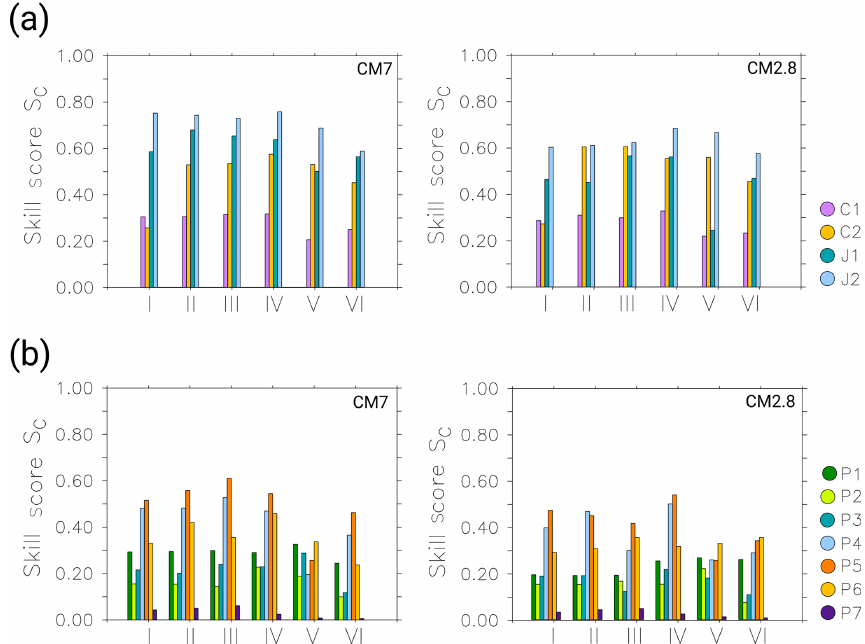
Figure 16. The bar plots show the calculated skill scores S C for the comparison of forecast days one to six (horizontal axis) to the obser- vations. The colours refer to the different observations. Panel (a) displays the results for C1, C2, J1 and J2. Panel (b) shows the results for P1–P7. The CM7 and CM2.8 results are shown on the left and right side,